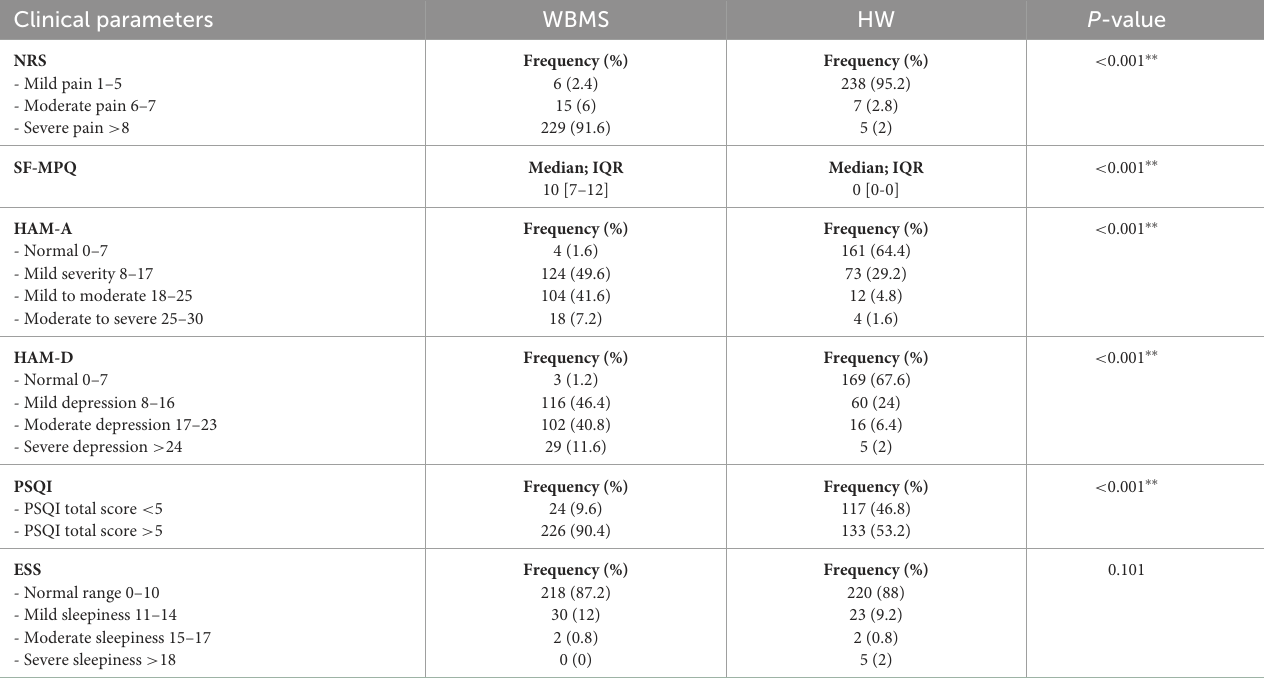
TABLE 4 Pain assessment, psychological profile and sleep in 250 WBMS patients and 250 HW. Clinical